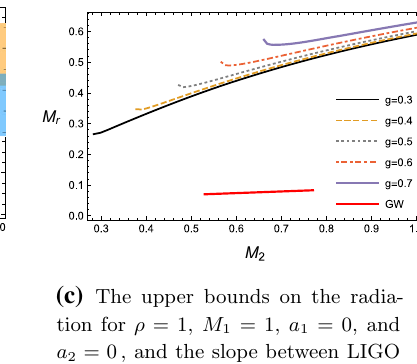
of g . As the value of g becomes large, the extremal spin parameter decreases, so that the spin parameter of the final black hole should be included in the extremal value at